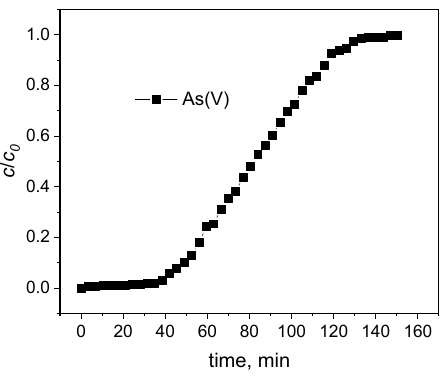
Figure 6. Breakthrough curve of As(V) adsorption by permethylated β -CD impregnated Amberlite XAD-4 resin .